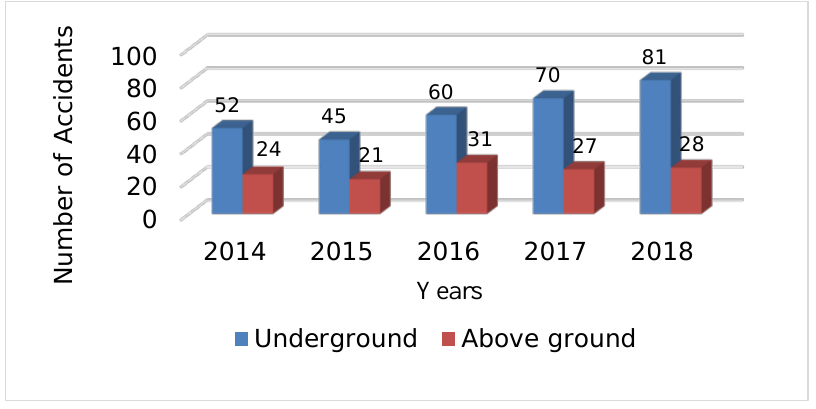
Figure 3. Underground and Aboveground Distribution of Accidents Arising from 2014 to 2018 Types of accidents that took place between 2014 and 2018 are classified as suffocation and poisoning from gas, collapsing of rocks and coal, falling of material, material stroke, hand transportation, mechanical transportation, road transportation, electricity, machinery, working machines, hand tools and other subheadings. It is very much fortunate to see that all these accidents have not caused any loss of lives between 2014 and 2017 except in 2018. The cause of the only death in 2018 was hearth attack. Among these years, accidents occurred mainly due to rocks and coal falling (39), material stroke (59), hand transportation (79) and other (162) reasons (Figure 4). Figure 5 shows the weight of accidents for the years in concern and Figure 6 shows the probability of accidents for the same period.